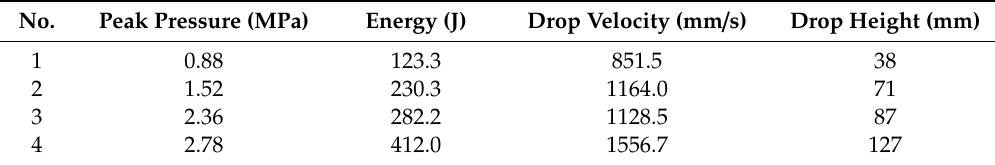
Table 2. Drop height of impactor with drop mass using energy equivalence.